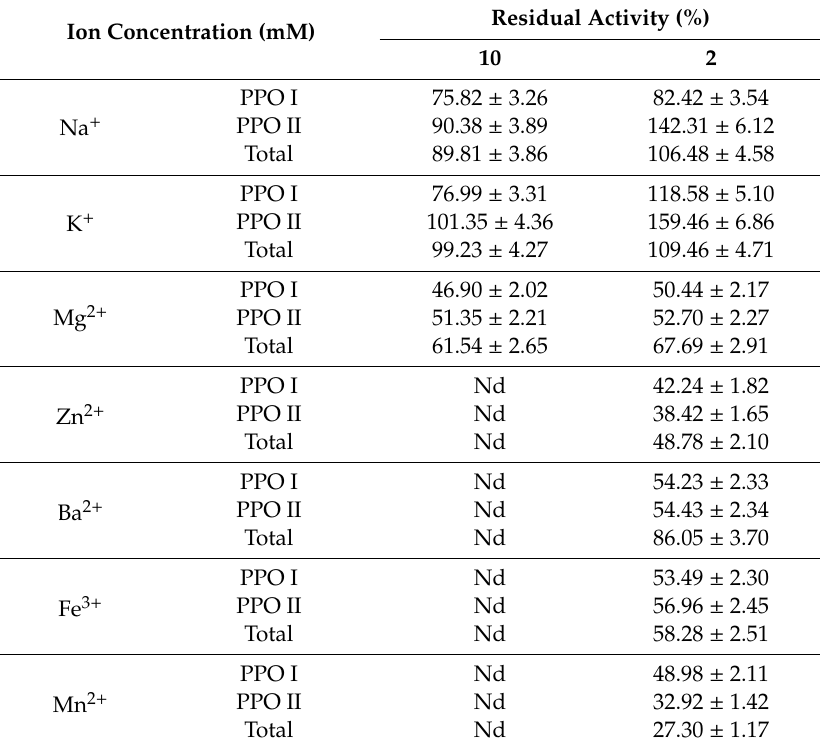
Table 4. E ff ects of metal ions on the activity of PPOs from lentil